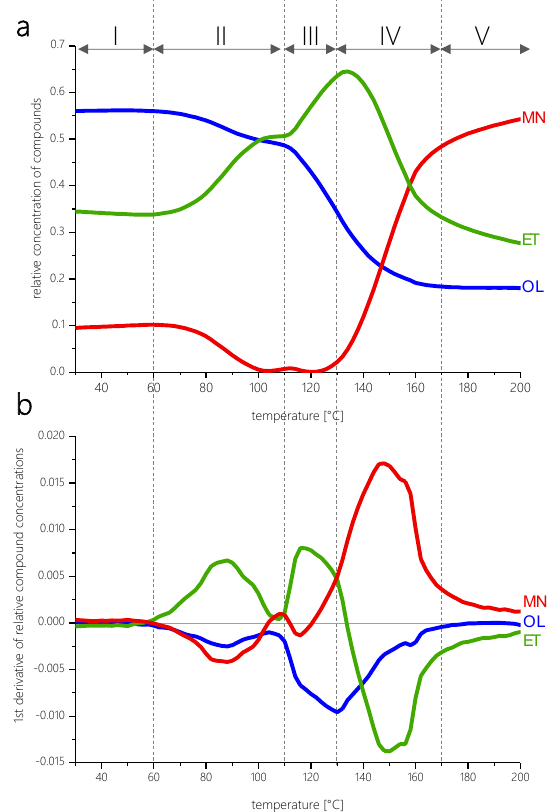
Figure 3. Spectroscopic concentration profiles. ( a ) Relative changes in proportions of the three identified spectral components OL, ET, and MN over temperature, and ( b ) the first derivative representing the relative rates of changes in dependence of the temperature. Five distinct phases of resin cure are indicated by Roman numerals.